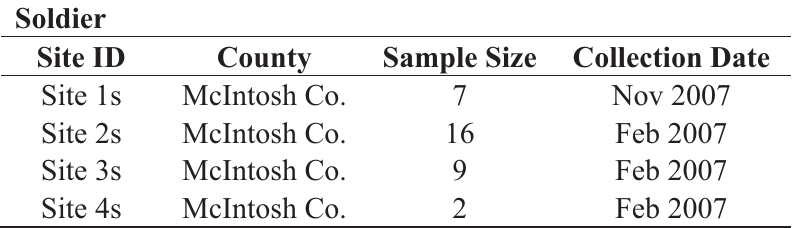
Table 2. Collection information by site number, county (McIntosh Co. = Sapelo Island, Thomas Co. = Thomasville), sample size, and collection date by caste (s = soldier, a = alate) for specimens of R. nelsonae used for morphological